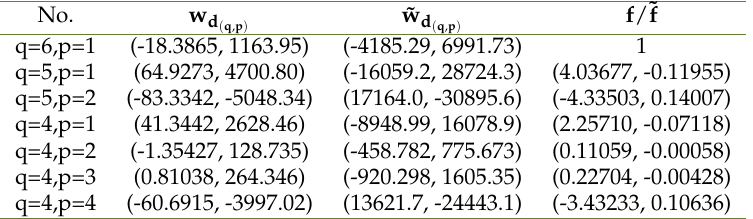
Table 3. TIFV using Daubechies 4.